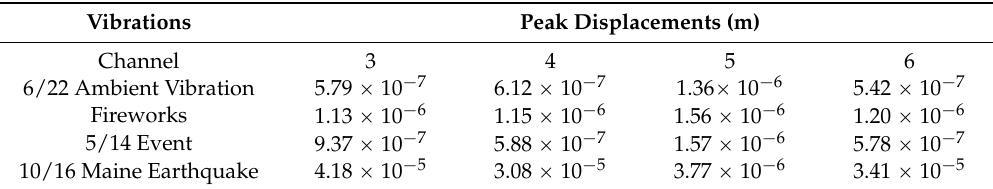
Table 4. Peak displacements at the vertical accelerometers.